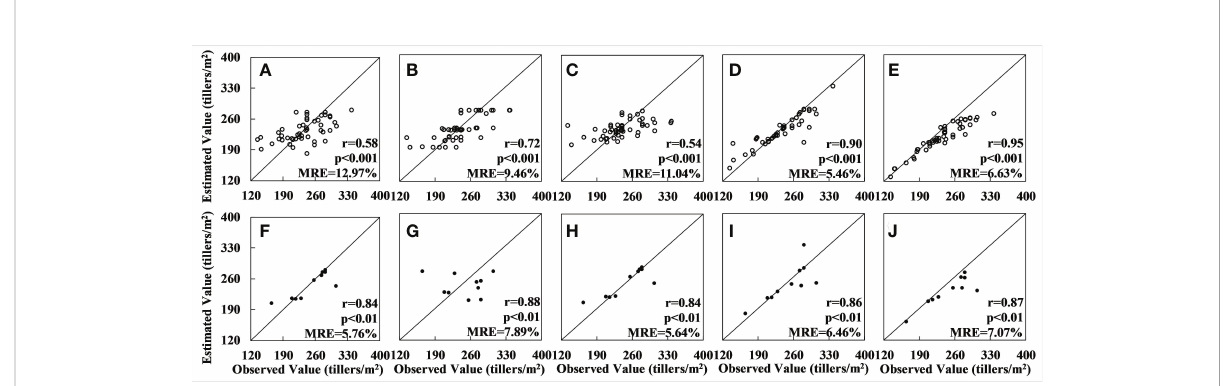
FIGURE 3 Accuracy of tiller density estimates based on the UAV hyperspectral data: (A – E) show the regression results for applying, respectively, the OLS, RF, SVM, GBRT, and XGBoost models to the training set; (F – J) show the regression results for the applying the same fi ve models to the validation set.